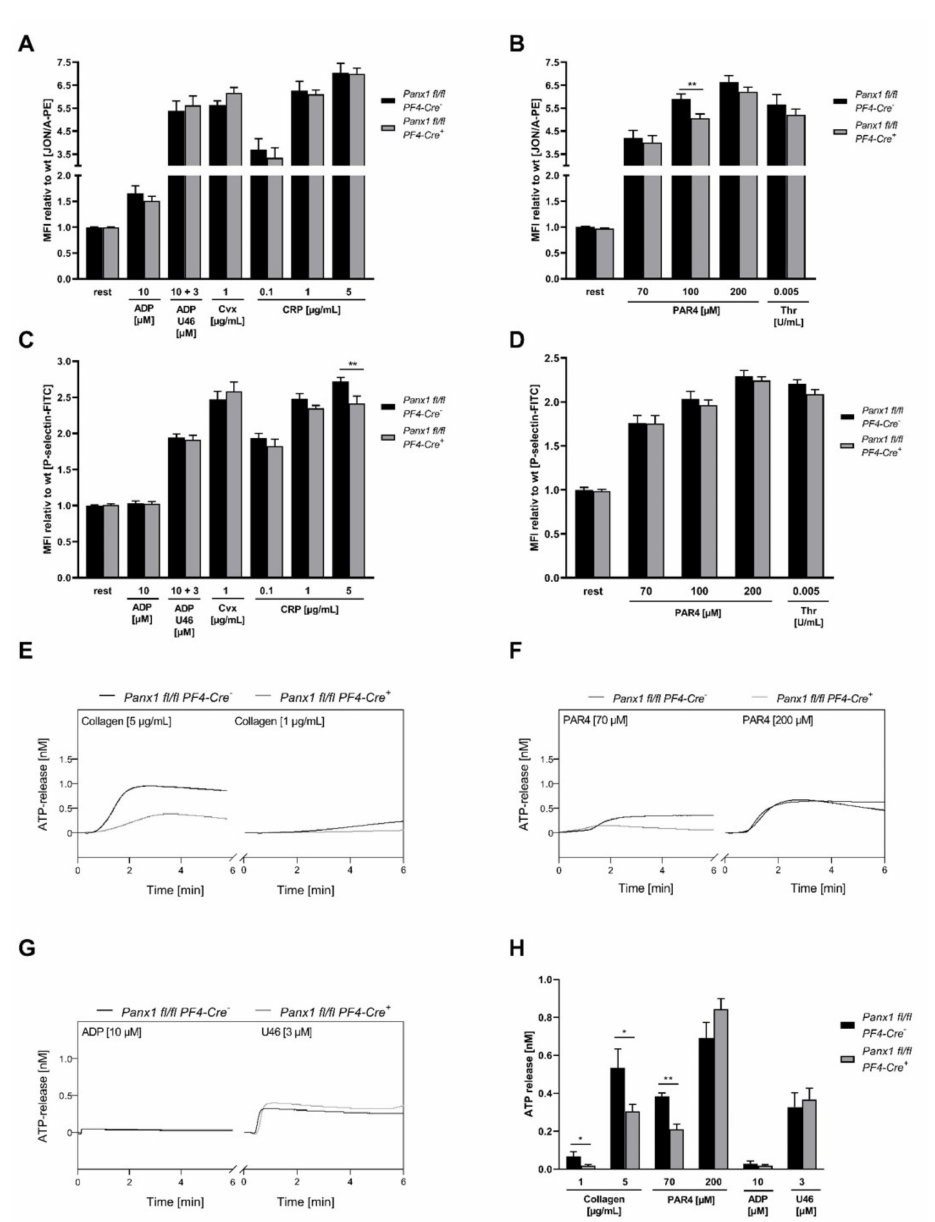
Figure 4. Platelet specific deletion of PANX1 only slightly affects integrin activation and P-selectin exposure but alters the release of ATP from platelets: ( A – D ) Washed murine whole blood was incubated with standard agonists and ( A , B ) integrin α IIb β 3 activation (JON/A-PE, n = 10–14) and ( C , D ) P-selectin exposure were determined by flow cytometry ( n = 10–15). ( E – H ) Isolated platelets from Panx1 fl/fl Pf4-Cre - (WT) and Panx1 fl/fl Pf4-Cre + (KO) mice were stimulated with indicated agonists for 6 min and ATP release was measured in the presence of apyrase (0.04 U/mL) using a luciferin/luciferase bioluminescent assay. Representative curves of ATP release following platelet activation with ( E ) 5 and 1 µ g/mL collagen ( n = 5–6), ( F ) 70 µ M and 200 µ M PAR4 peptide ( n = 3–5) and ( G ) 10 µ M ADP and 3 µ M U46619 ( n = 4–5) using platelets from PANX1 WT and KO mice. ( H ) The bar graph depicts mean values of maximal ATP release for all tested agonists in the presence of apyrase (0.04 U/mL). Statistical analyses were performed using ( A – D ) a two-way ANOVA followed by a Sidak’s multiple comparisons post-hoc test and ( H ) an unpaired multiple students t-test. Bar graphs indicate mean values ± SEM, * p < 0.05 and ** p < 0.01. Rest = resting, CRP = collagen-related peptide, Cvx = convulxin, PAR4 peptide = protease-activated receptor 4 peptide, ADP = adenosine diphosphate, U46619 (U46) = Thromboxane analogue, Thr = thrombin, WT = wild type, KO = knock- out, MFI = Mean fluorescence